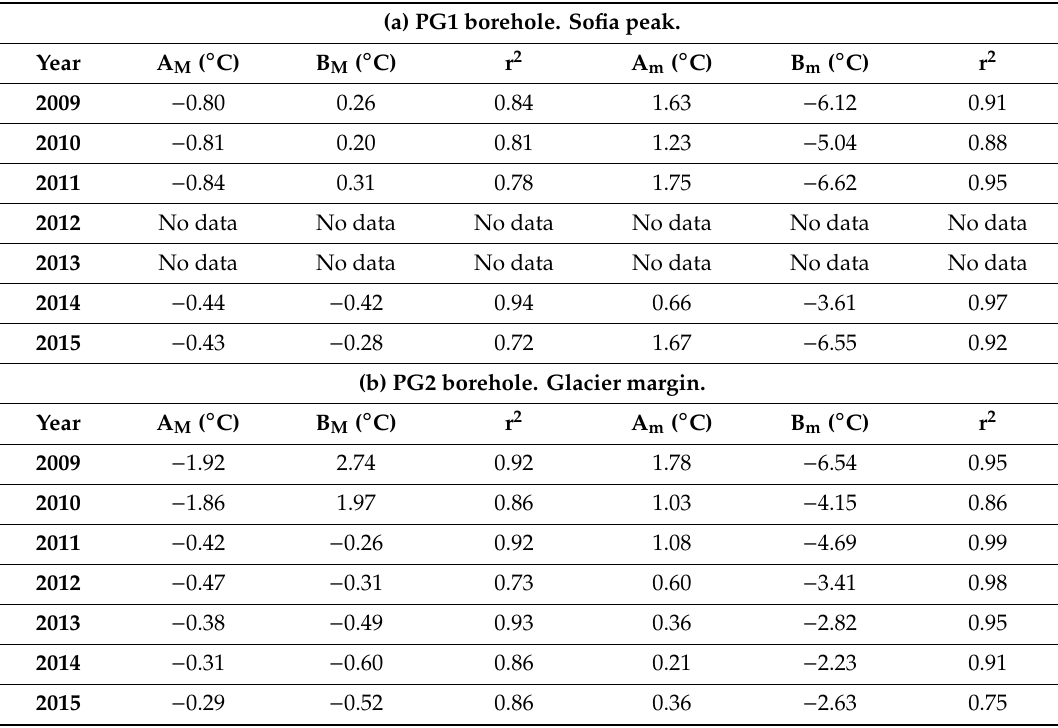
Table 2. Logarithmic fit parameters for the annual extreme (maximum and minimum) ground temperature profiles for the borehole PG1 (a) and PG2